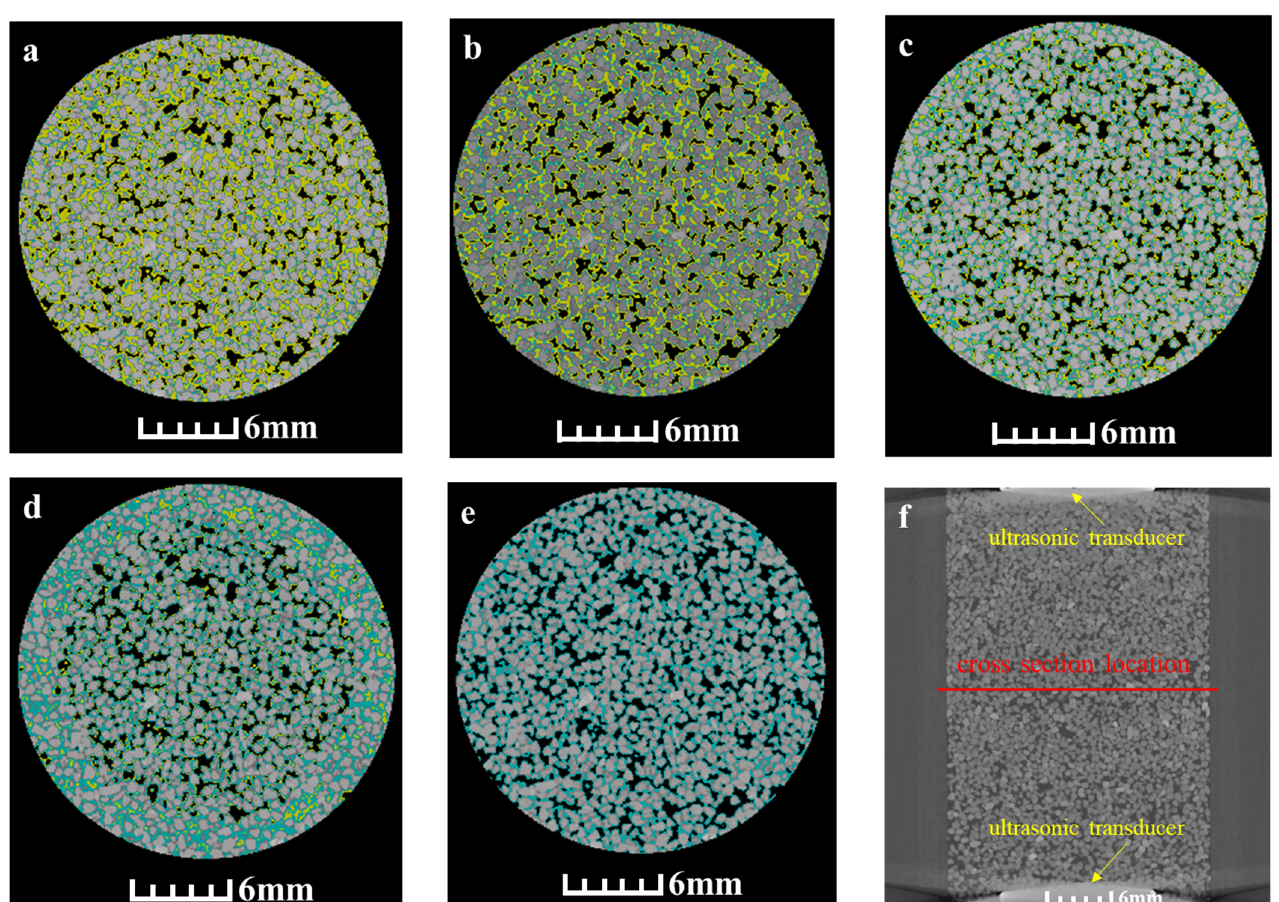
Figure 5. X-CT images of a sample cross-section during hydrate dissociation. Where ( a – e ) represent different dissociation stages, corresponding to the points in Figures 2–4. ( f ) represents an overall schematic of a sample scan. Yellow represents methane hydrate, blue represents NaCl solution, light gray represents sand, and black represents methane gas.